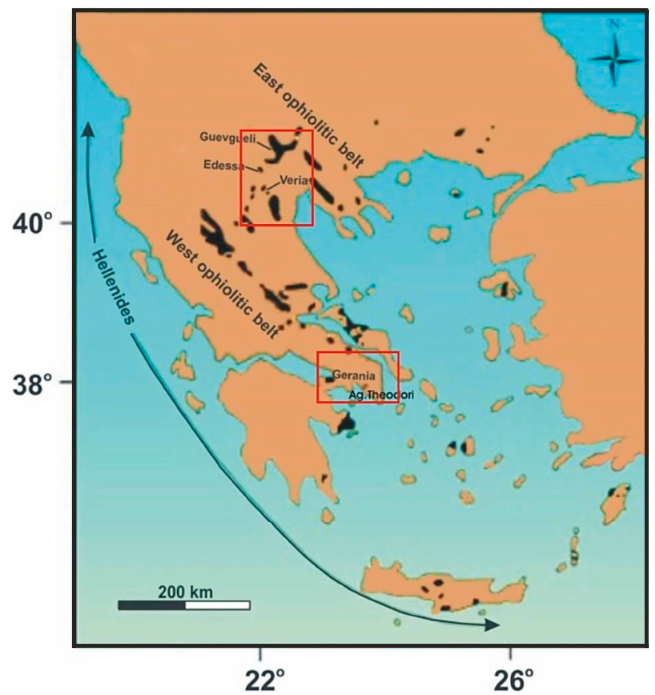
Figure 1. Simplified map showing the sampling areas in the red rectangles.